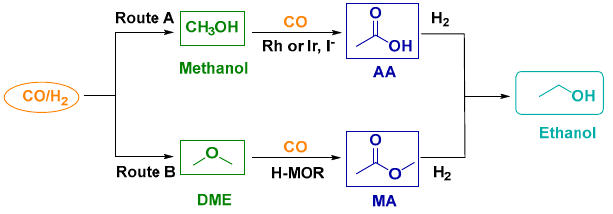
Figure 6. Scheme for ethanol formation via common multi-step reactions.